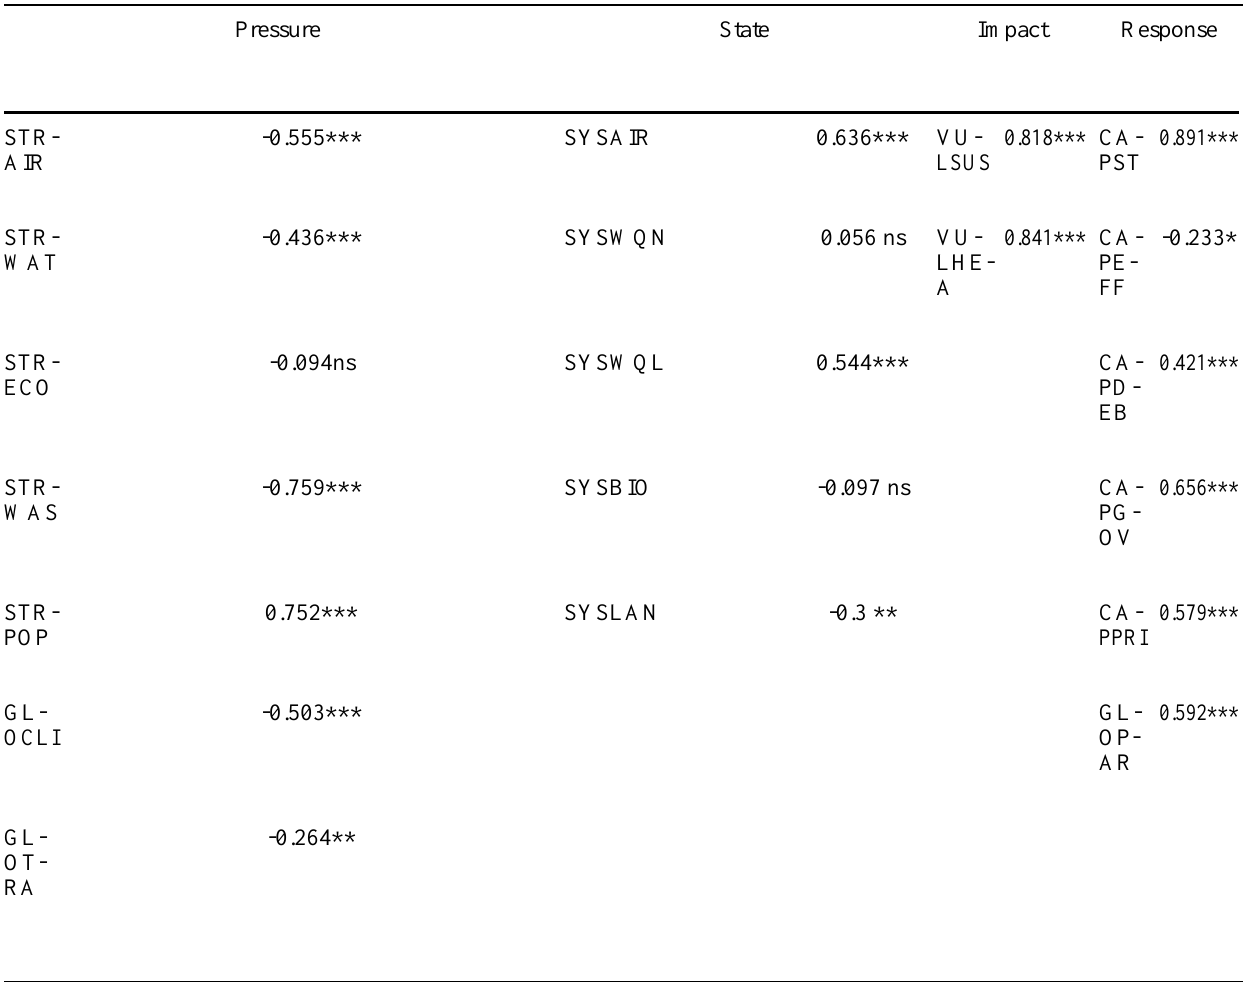
Table 4. Correlation coefficients for the PSIR components of the ESI 2002 and logarithm GDP